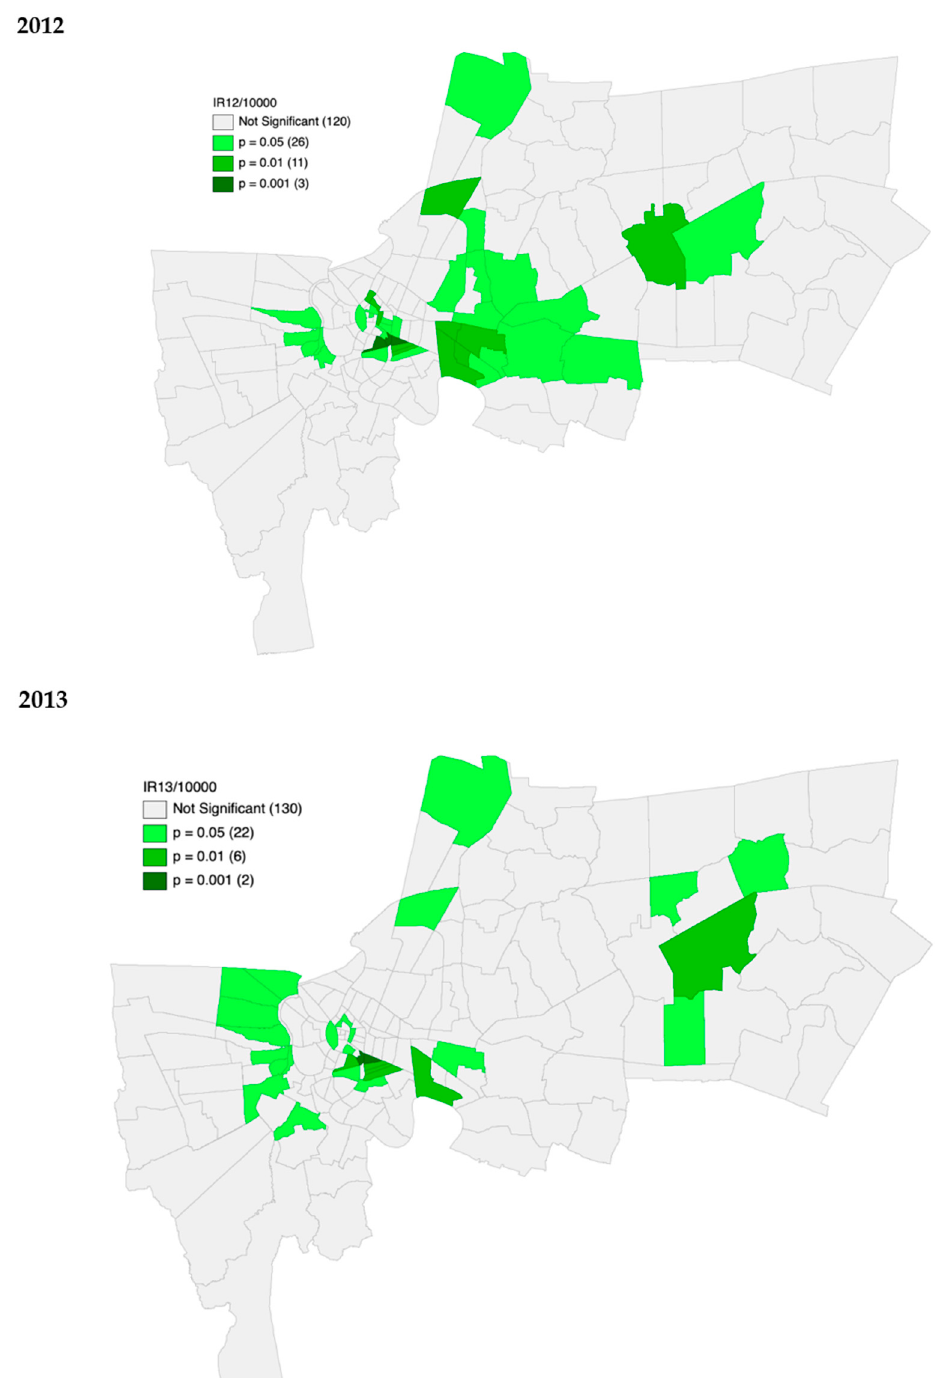
Figure A4. LISA significance maps for 2012 and 2013 Dengue Incidence Rate.